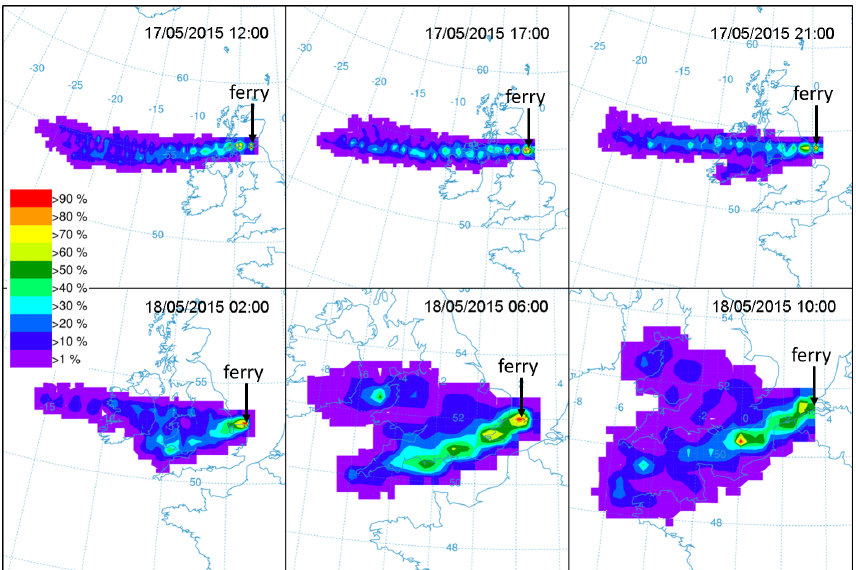
Figure 2. Backward trajectory frequencies for a south-bound sailing with westerly wind conditions (sailing start 17 May 2015 12:00, end 18 May 2015 10:00). The coloured contours represent the normalised frequency counts (number of end points in a 0 . 5 ◦ × 0 . 5 ◦ grid cell divided by the maximum number of end points in any grid cell, expressed as a percentage) and the source corresponds to the location of the ferry (indicated by an arrow). The trajectories were run backward for 24h at 3h intervals using GDAS 1 ◦ global meteorology (NOAA, 2018).